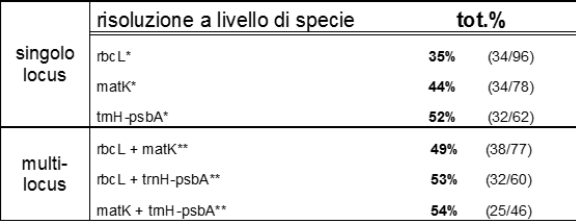
Table 3. Discriminating power of Barcoding